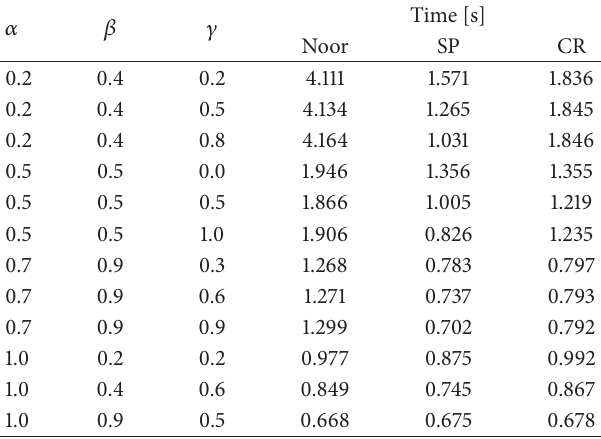
Table 7: Times of polynomiograph’s generation for 𝑝 2 using three parameters iterations.